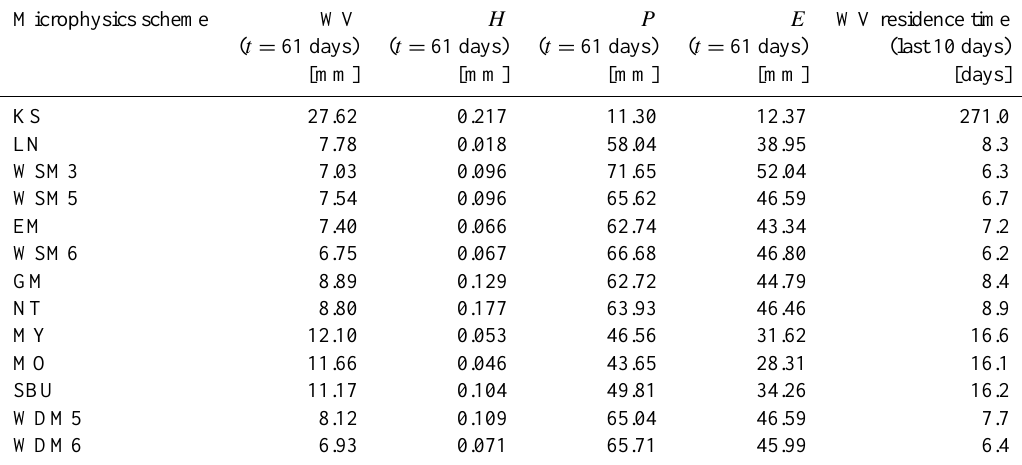
Table 4. Mean column density values of water vapour WV, hydrometeors H , accumulated precipitation P and accumulated evaporation E at the end of the simulation. The initial total water mean column density is 26.93mm for all the schemes and it is solely under the form of water vapour. The values of H are from the series filtered with a 10day lowpass filter and are shown with 3 decimal digits instead of 2 due to the lower magnitude of H compared to the other components of the water cycle. The last column of the table shows the mean residence time of water vapour for the last 10 days of the